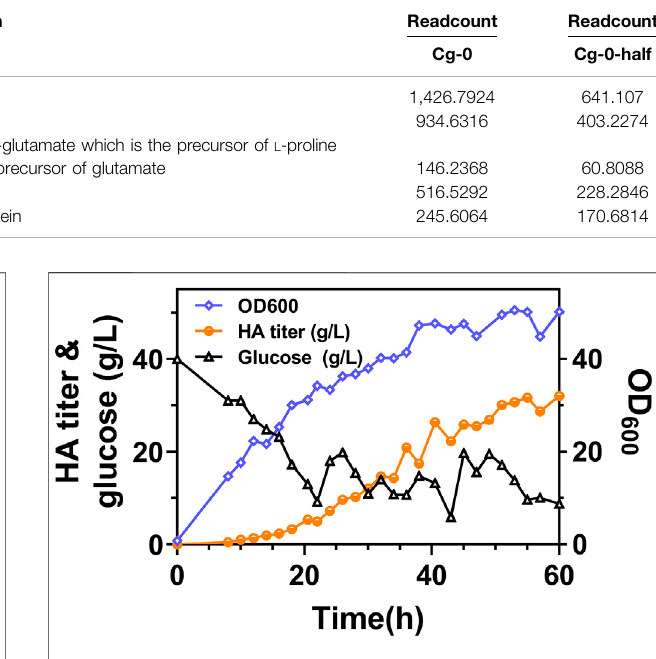
FIGURE 7 | The time pro fi les of fed-batch fermentation by Cg-dR-CLS. Glucose feeding started at 22